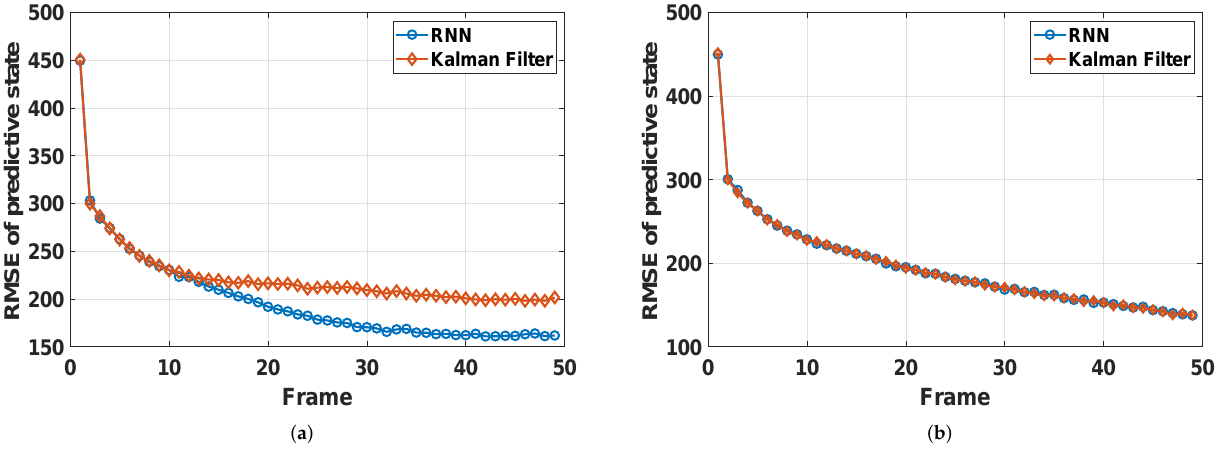
Figure 9. RMSE comparison of predictive state of different methods. ( a ) Target 2 ( b ) Target